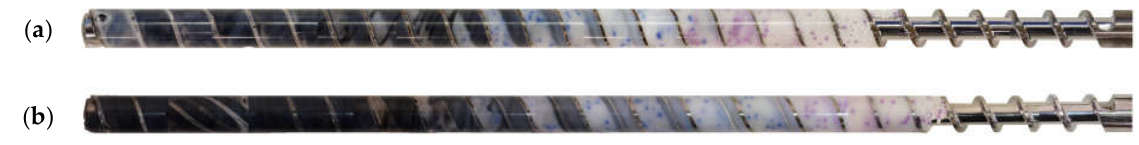
Figure 4. Top views of the frozen‐screw pulls: ( a ) General purpose, square‐pitched screw; ( b ) Barrier screw with melt channel, barrier flight, and mixing element.